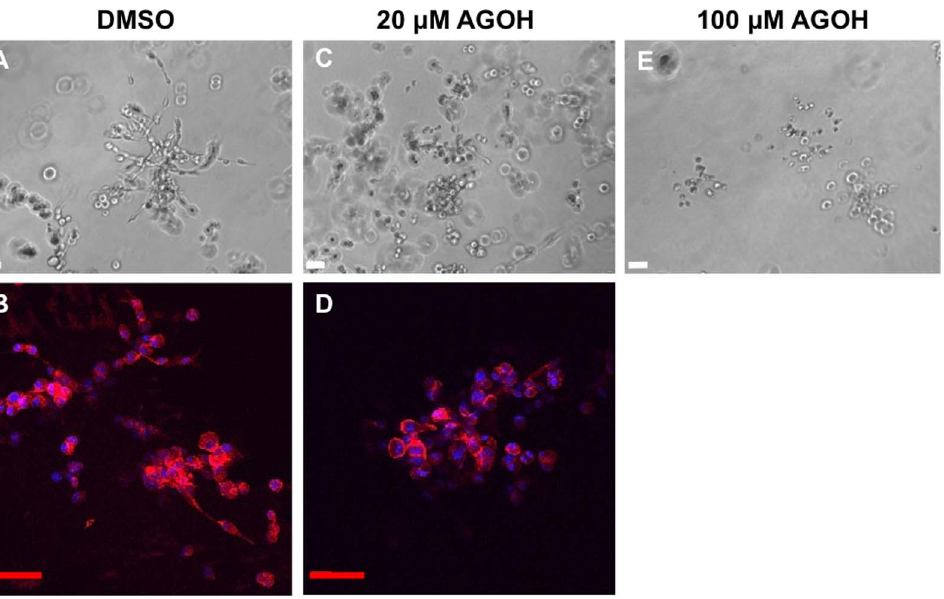
Figure 3. AGOH inhibits 3D invasive growth of MDA-MB-231 cells. MDA-MB-231 cells were seeded in Matrigel and treated with AGOH at the indicated concentration. After culturing for 8 days, phase contrast images were taken from randomly chosen fields (A, C, E) or Matrigel containing colonies were fixed and immunostained for F-actin (phalloidin, red) and nuclei (DAPI, blue) (B, D). The representative images from three separate experiments are shown. Scale bars represent 50 m